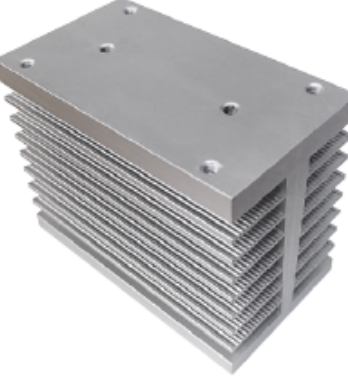
Figure 2. Relpol RH17A heat sink.